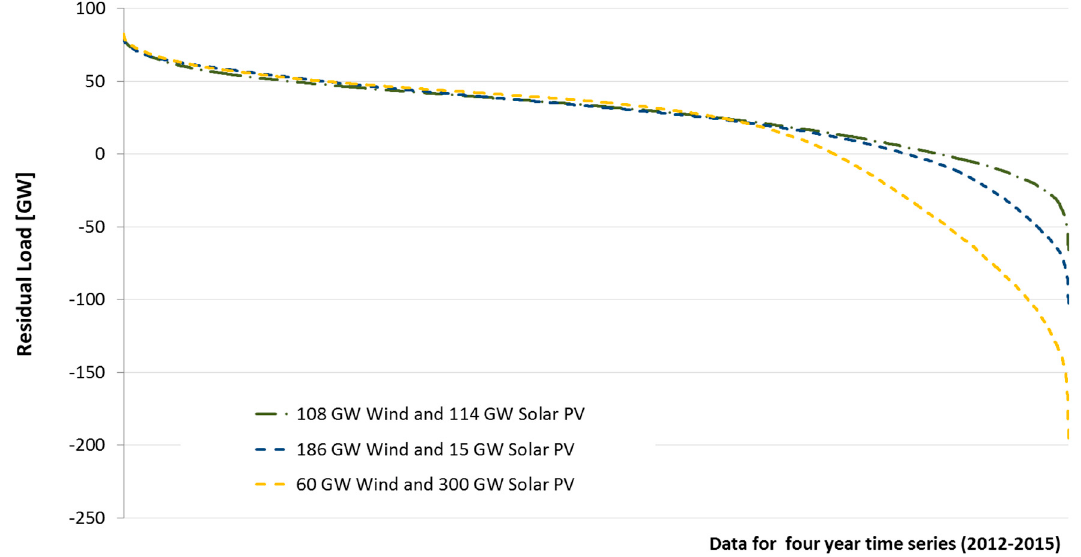
Figure 11. Residual load duration curve (RLDC) of different combinations of wind and solar PV all achieving a 50% REN share in Case B.